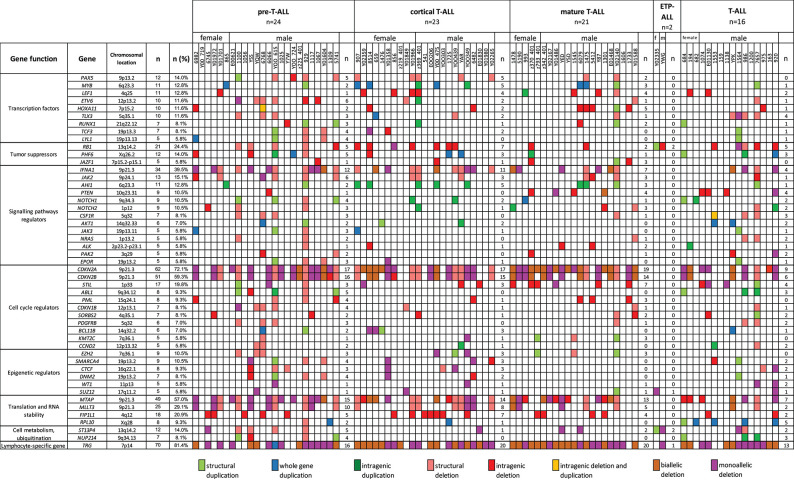
Overview of molecular alterations identified in 86 samples according to particular subtypes of T-ALL. Heat map represents genes in which CNAs have been identified in at least 5% of patients.